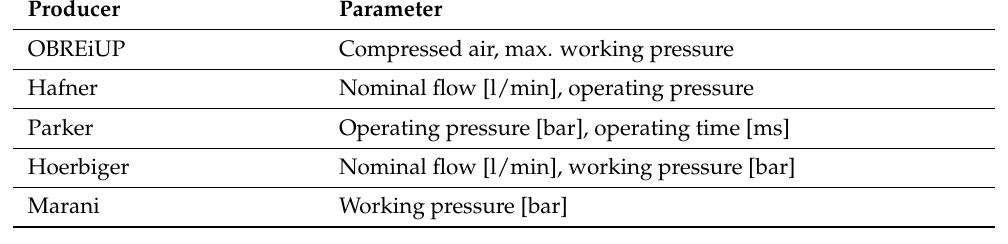
Table 1. List of catalog parameters of pneumatic elements.